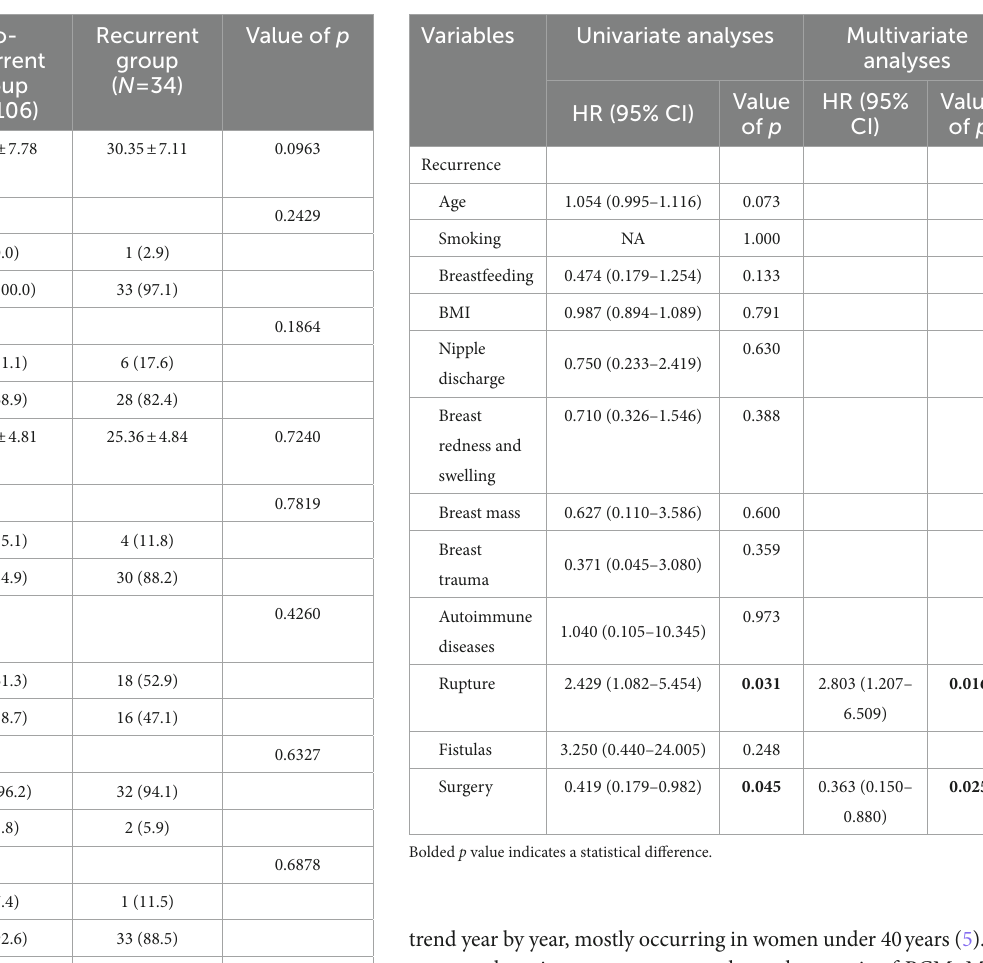
TABLE 3 Factors of postoperative recurrence in PCM patients with nipple depression receiving surgical